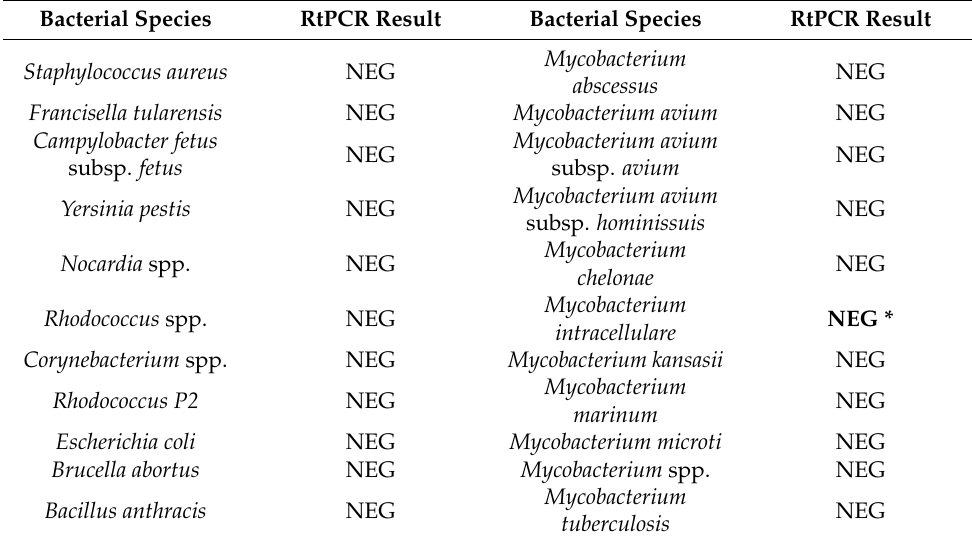
Table 2. Specificity test of real-time